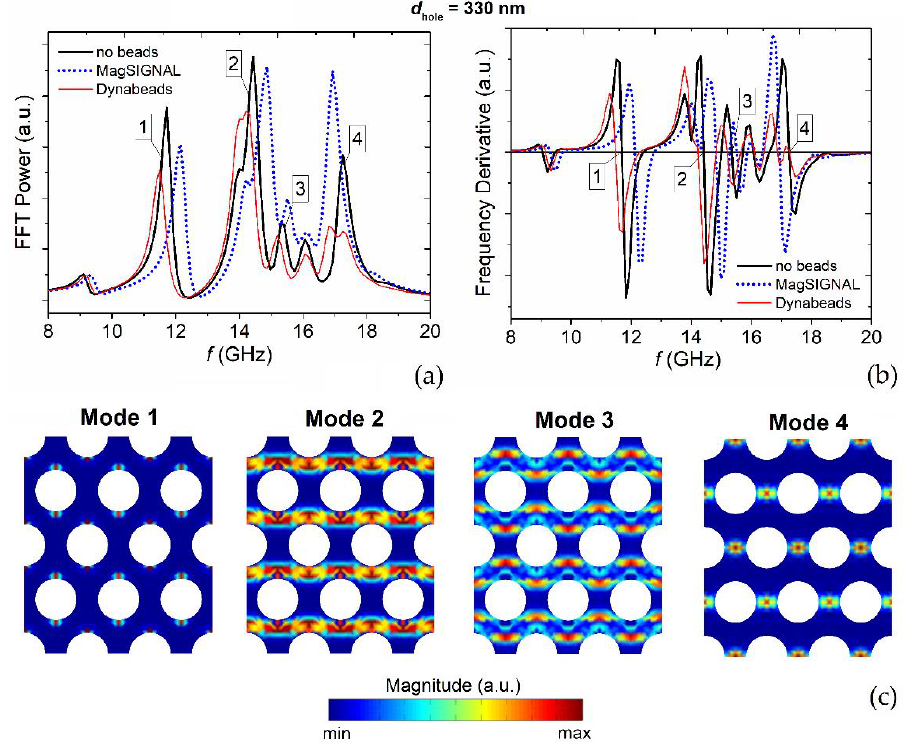
Figure 4. ( a ) FFT power spectra of the average magnetization component along the excitation field direction ( x -axis), for a bias field of 150 kA/m parallel to the y -axis. The graph shows the FMR responses of the permalloy nanostructured film with 330 nm holes to the stray fields generated by the MagSIGNAL-STA and Dynabeads MyOne beads trapped at the holes, assuming that the film surface is fully covered by beads. The case without beads is also reported for comparison. ( b ) Corresponding frequency derivatives of the FFT power spectra. ( c ) Surface plots of Fourier coefficient magnitude for the FMR modes indicated in ( a ) and ( b ), calculated in a magnified area of the film for the case without beads.